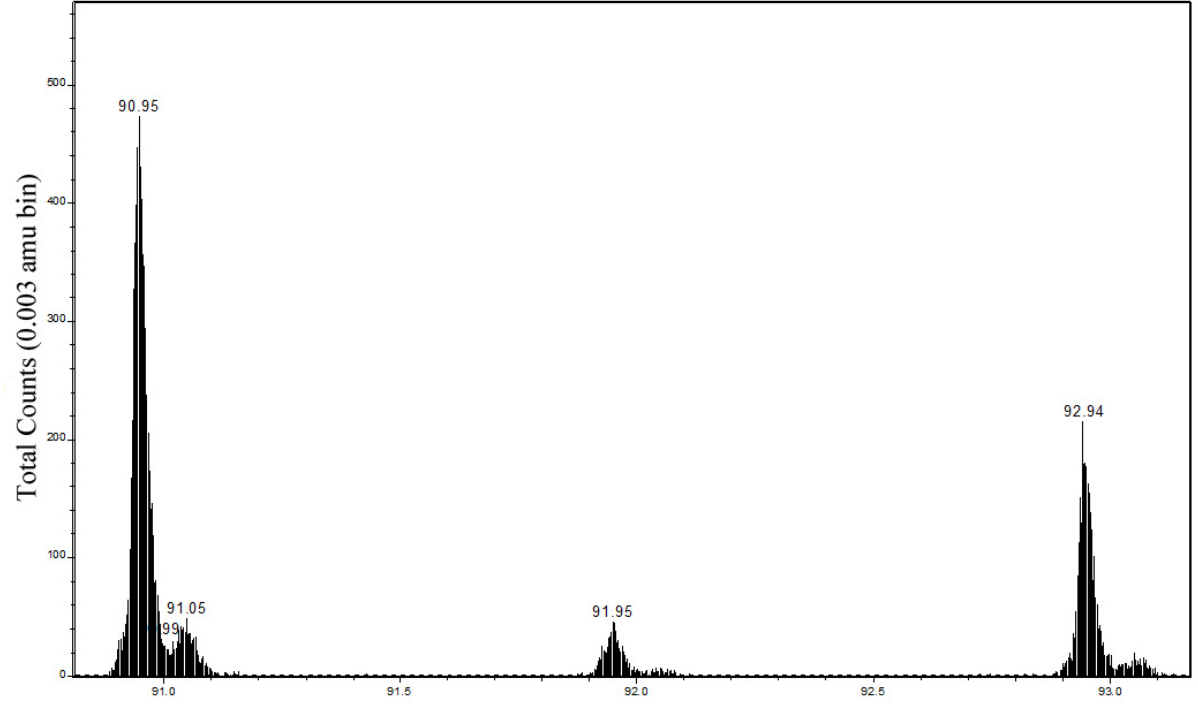
Figure 3. Positive secondary ion mass spectrum in the m/z 91–93 region from bulk Cu hydroximate showing the doublet assigned to 63 CuNCH 2+ and 65 CuNCH 2+